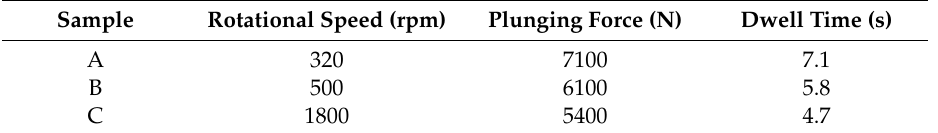
Table 1. Summaryofdown-selectedFSSPconditionsfordifferentpeaktemperatureanddifferentmicrostructures. Sample Rotational Speed